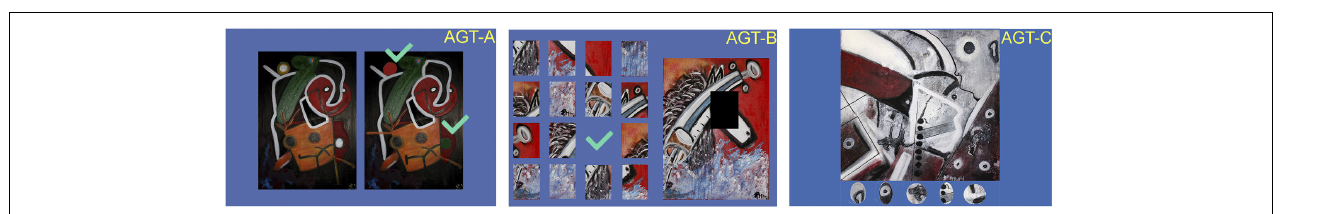
FIGURE 1 | Screenshots from the Art Gallery Test (AGT).